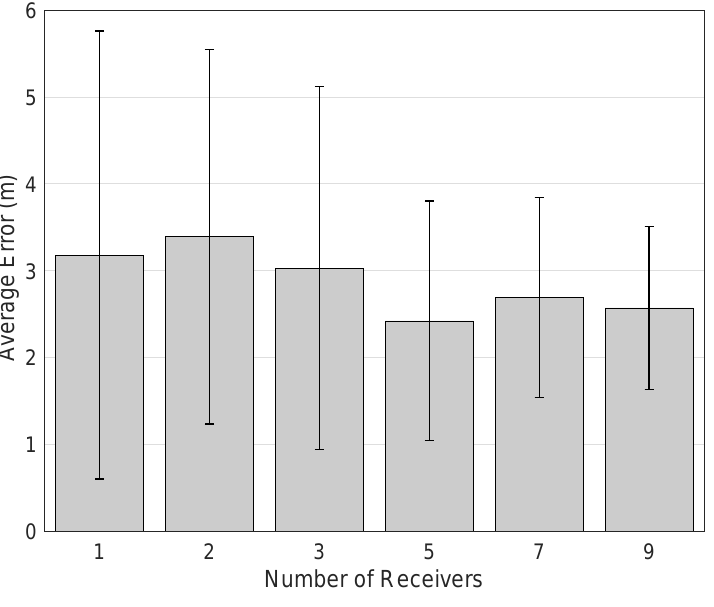
Figure 6. Effect of number of